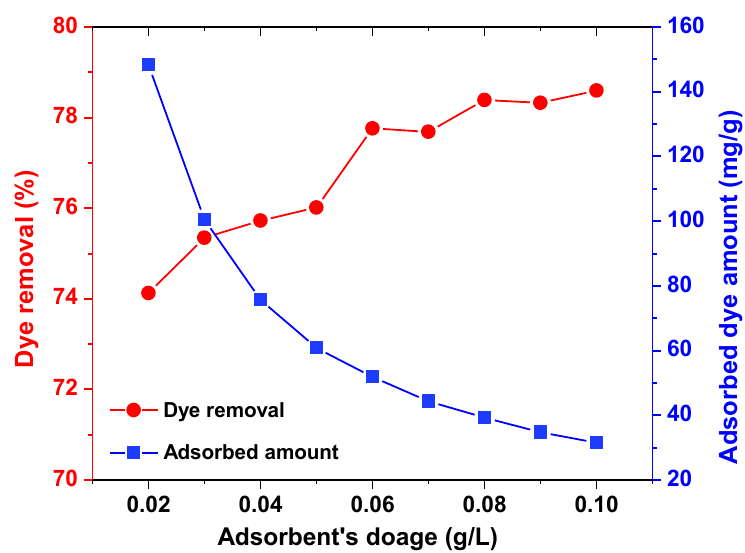
Figure 10. Effect of adsorbent dosage on AB92 adsorption by BFO/CFO nanocomposites.